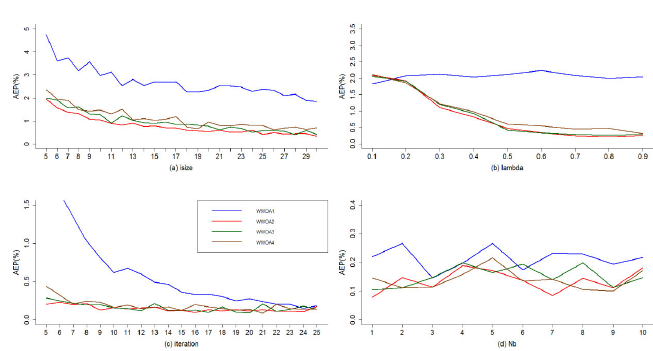
Fig. 1. Calibration of the parameters of the WWOA for small jobs